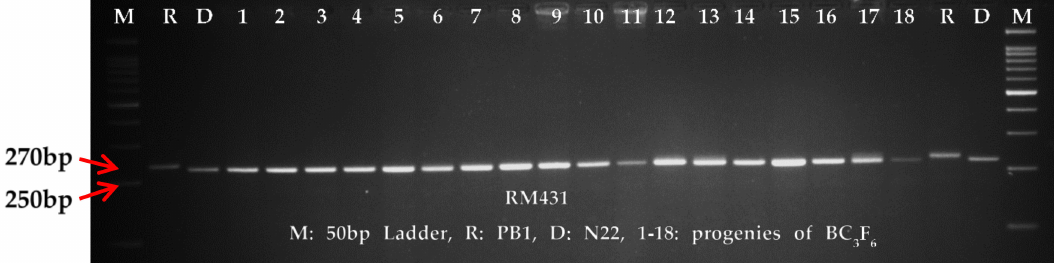
Figure 2. Foreground selection of PB1 near isogenic lines (NILs) for qDTY1.1 using the marker, RM 431.